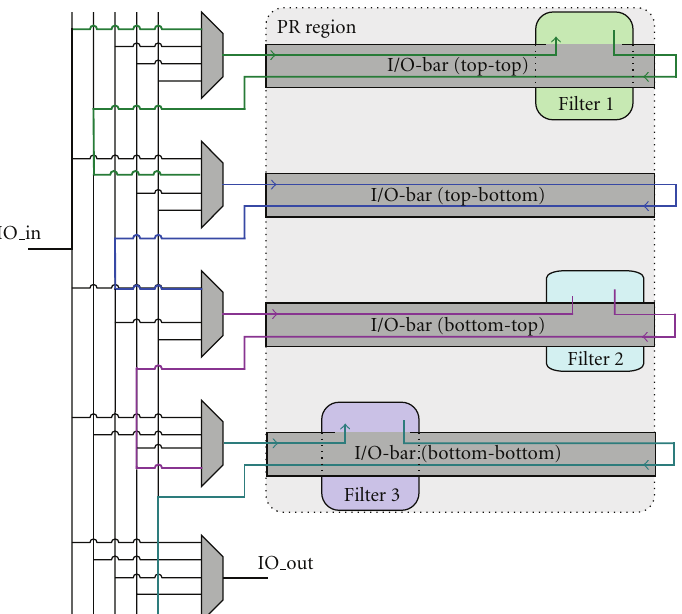
Figure 3: I/O bar used for streaming data through PR region.